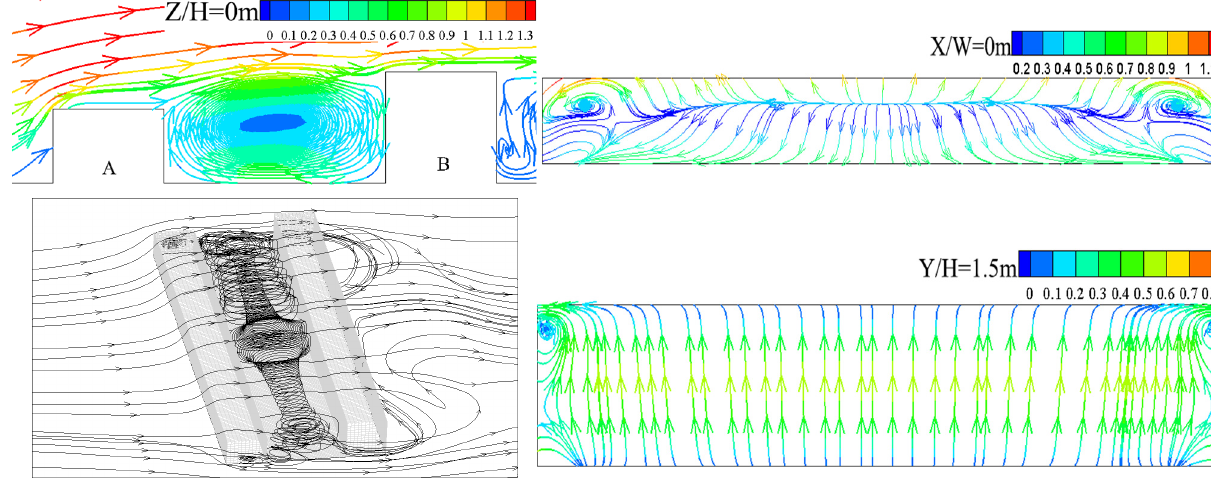
Figure 10. Plane streamline diagram and three-dimensional flow field diagram in the step-up street with an ASF = 2/3.